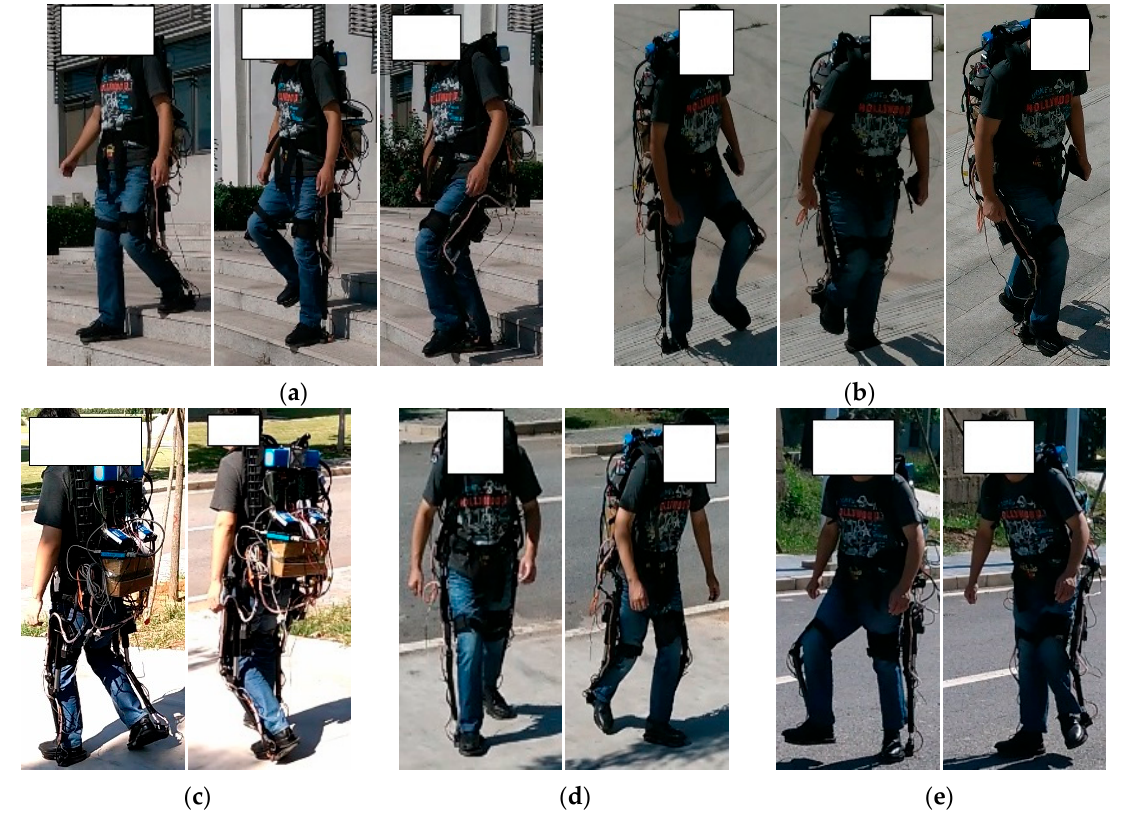
Figure 12. Experiments for locomotion mode identification. ( a ) Stair descent; ( b ) Stair ascent; ( c ) Ramp descent; ( d ) Ramp ascent; ( e ) Level-ground walking.